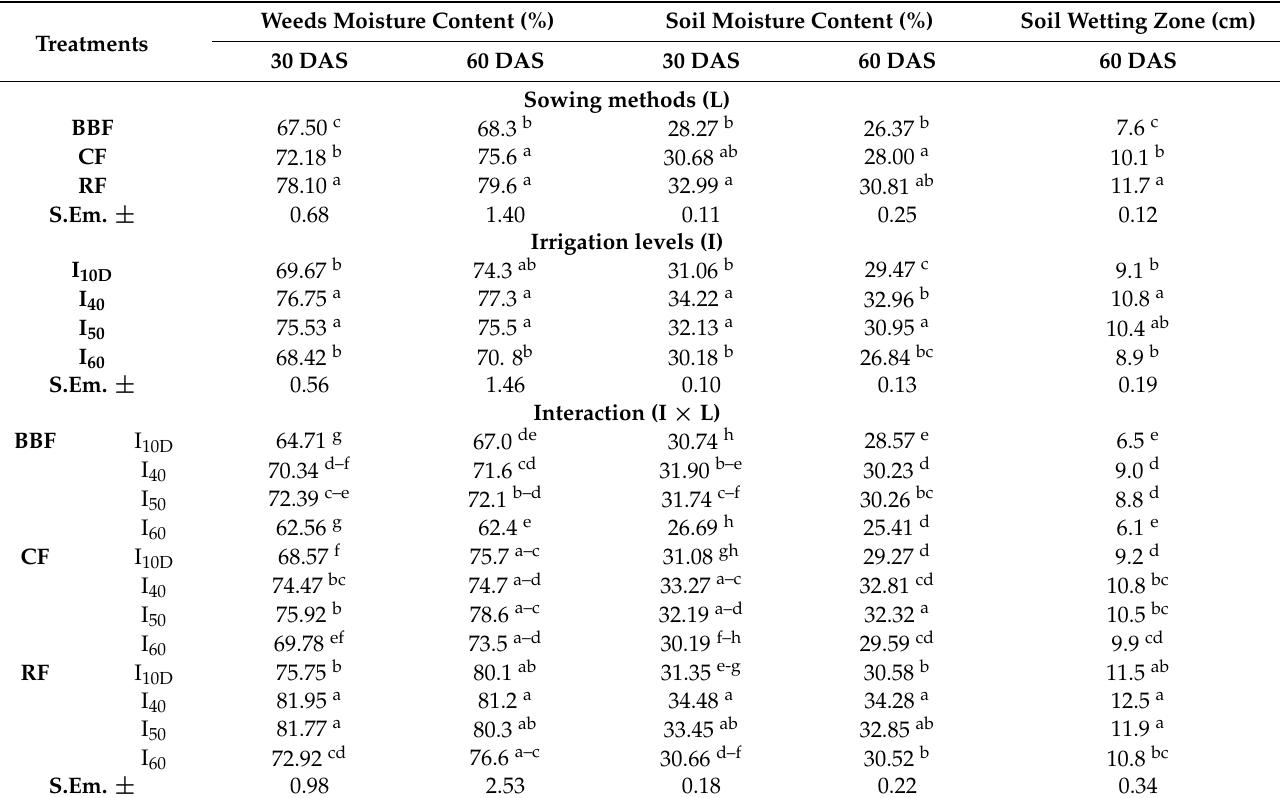
Table 5. Moisture content of weeds, soil and lateral wetting zone in maize influenced by sowing methods and irrigation levels (pooled data of 2015 and